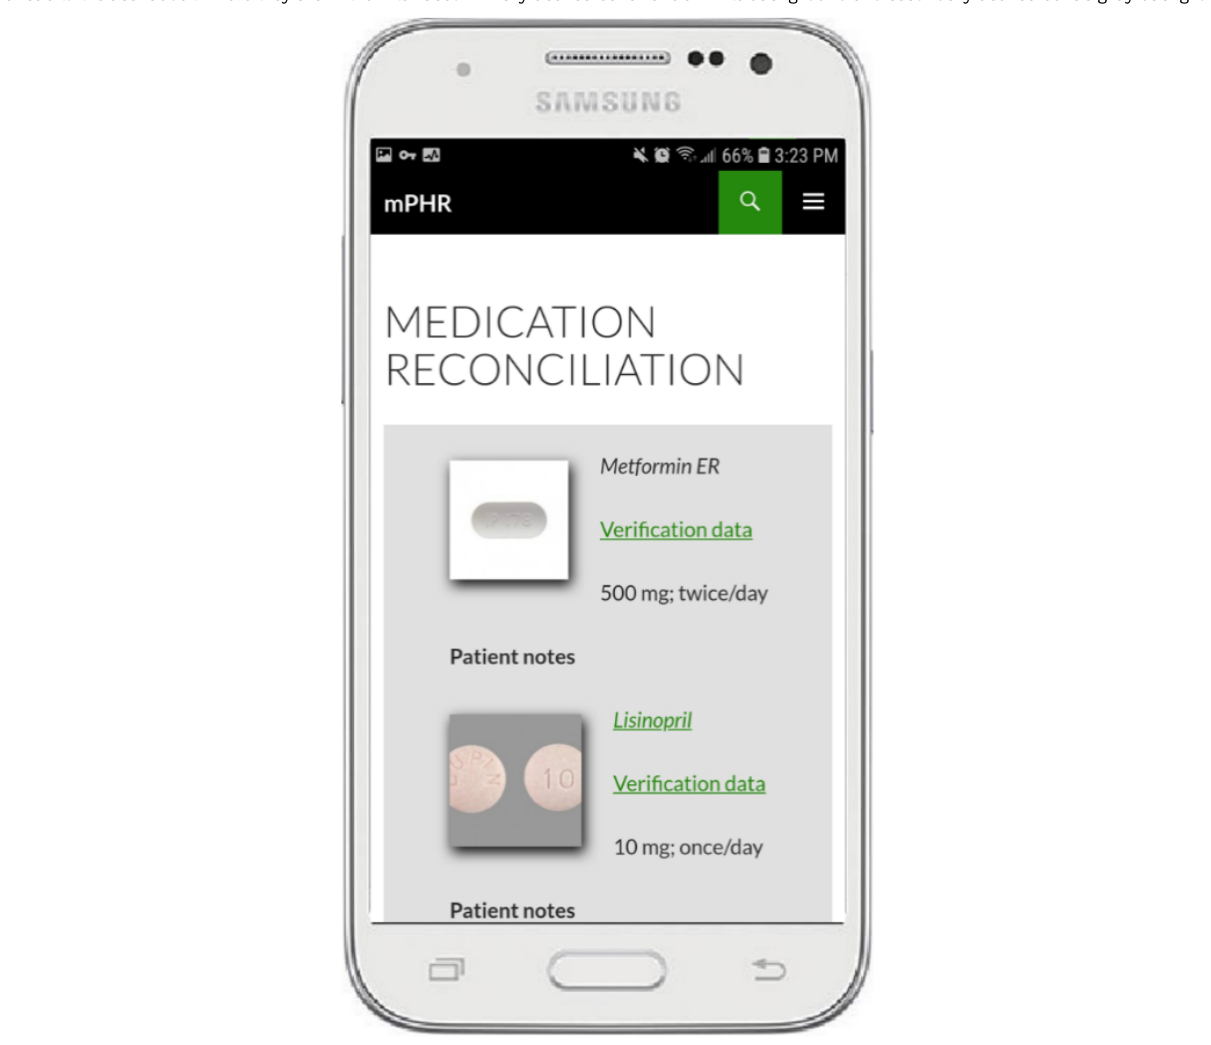
Figure 6. Example Samsung Galaxy Prevail LTE showing the provider view of the medication screen. The screen background provides an